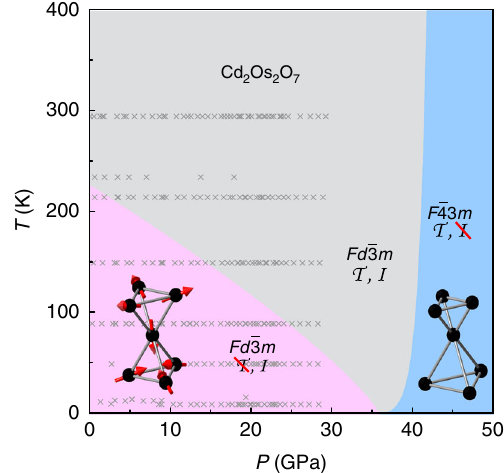
Fig. 1 Symmetries across the P – T phase diagram. The Cd 2 Os 2 O 7 lattice retains its cubic symmetry throughout the probed P – T phase space, but continuously transitions between Fd-3m and F-43m space groups. The Fd- 3m lattice symmetry was veri fi ed by optical Raman scattering from 0 – 29 GPa and 10 – 300 K (gray crosses), while both phases of magnetism and structure (pink and blue shading) were inferred from X-ray diffraction measurements at T = 4 K. The metallic paramagnetic phase in the low- pressure Fd-3m space group has both spatial inversion ( I ) and time reversal ( T ) symmetries. For the spin degrees of freedom, time reversal symmetry is broken in the low-pressure AIAO phase. On the high-pressure side, the F-43m space group breaks the spatial inversion symmetry, introduces a tetrahedral breathing distortion (inset), and restores the time reversal symmetry with disordered spins. The coincidence of continuous magnetic and structural phase transitions at a single quantum critical point suggests strong coupling between spin, orbit, lattice, and (potentially) charge degrees of freedom in this 5d pyrochlore